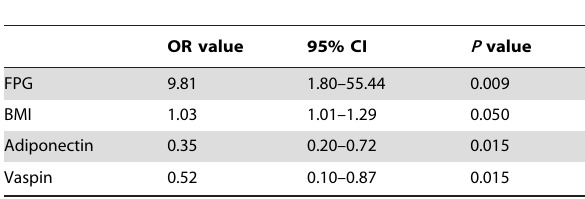
Table 3. Results of multiple stepwise logistic regression analysis for risk factors for new onset of T2DM in control group at